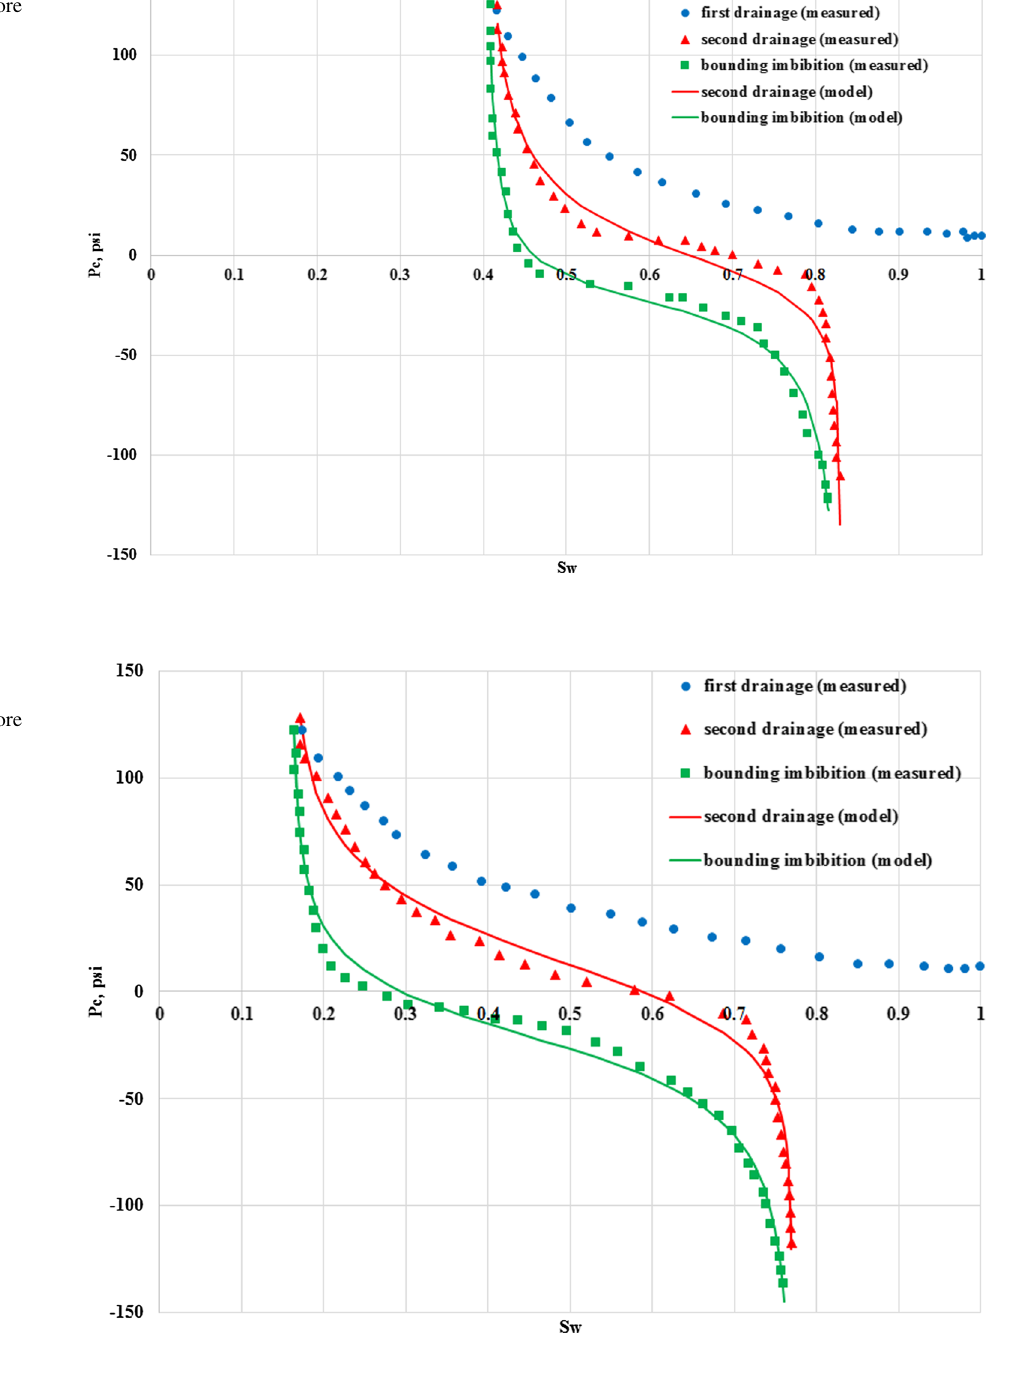
Fig. 7 Curve fitting of